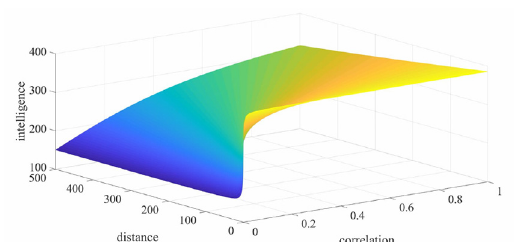
Figure 3. 3-D graph of correlation-distance- intelligence